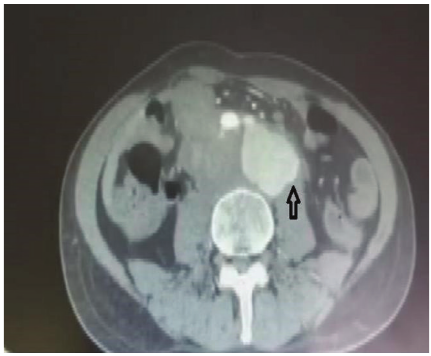
Figure 1: Large retroperitoneal mass.